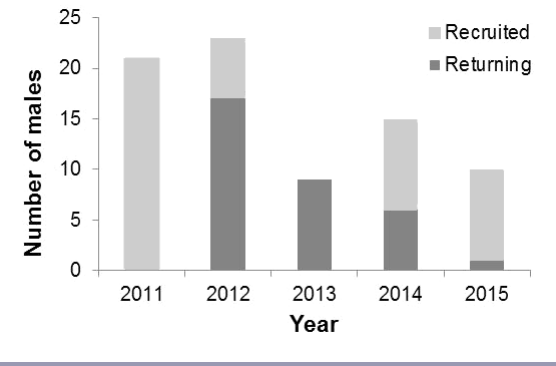
Fig. 4 . Numbers of territorial Black-headed Bunting ( Emberiza melanocephala ) males in the study plot at the end of June in years 2011 to 2015. The marking and vocal identification of male Black-headed Buntings started in May 2011. Returning males are those observed in previous